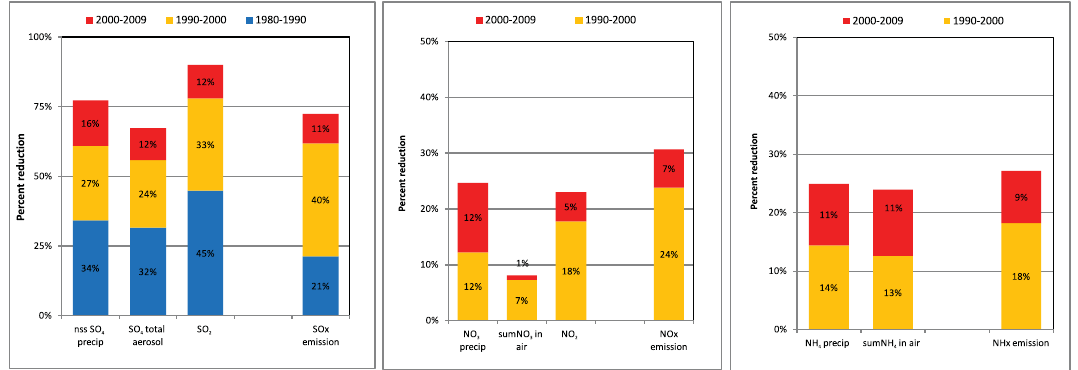
Fig. 2. Average observed reduction in sulphur and nitrogen components compared to the emission reductions in Europe for the different ten years period from 1980 for sulphur and 1990 for nitrogen. Sulphur trends are calculated from the 14 sites with measurements of all three components since 1980, while for nitrogen the same number of sites, as shown in Table 3, are used, and it is not necessarily the same site used for all the